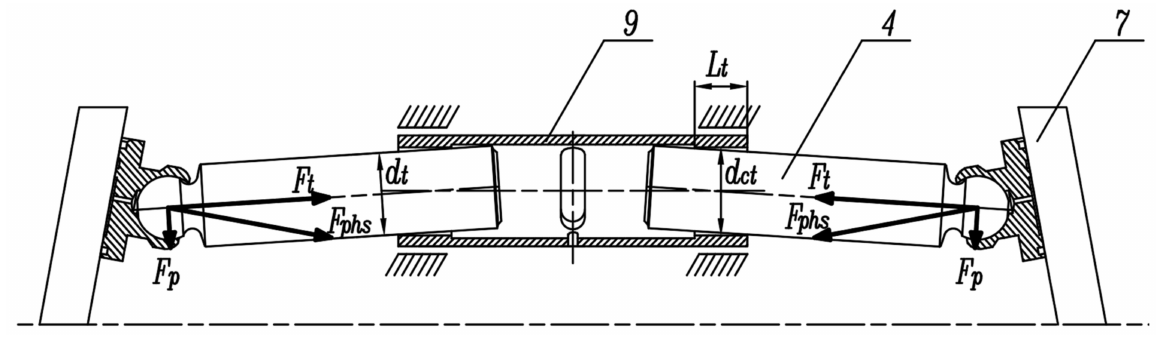
Figure 16. Skewed annular gap between the pistons (4) and commutation tube